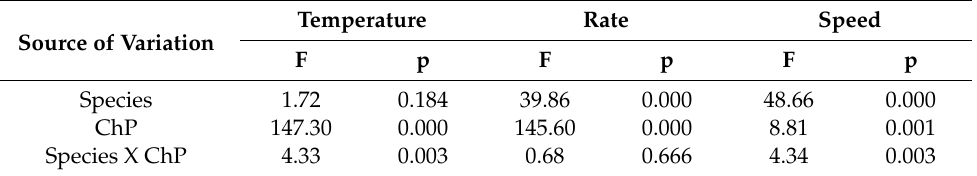
Table 3. Main results of the Anova on the characteristics of the